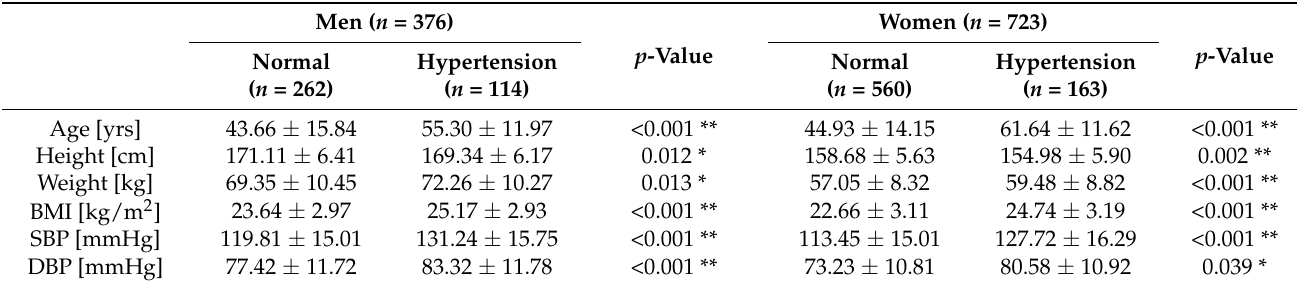
Table 3. General characteristics of subjects.